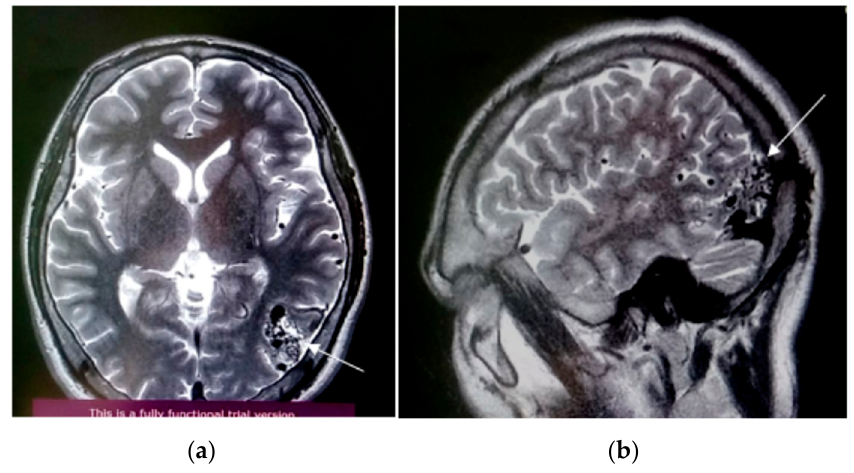
Figure 1. Axial ( a ) and sagittal ( b ) views of MRI obtained at initial presentation of the patient. AVM in the middle cerebral artery (MCA) and hypoplasia of cerebellar tonsils with subarachnoid hemor- rhage (SAH). Right sided sinusitis and ethmoiditis. White arrows indicate location of AVM on the